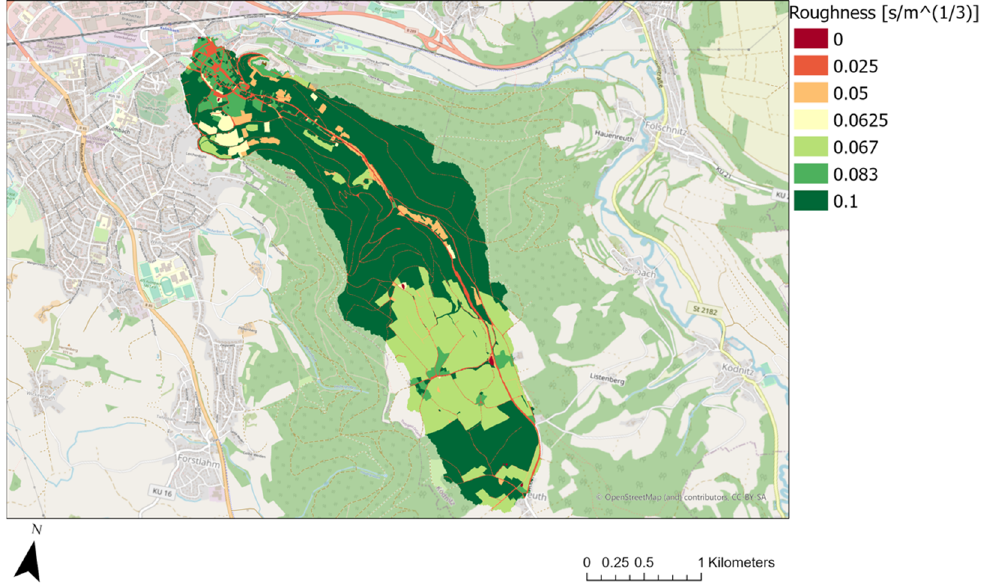
Figure 1. Applied Manning roughness coefficients for the case